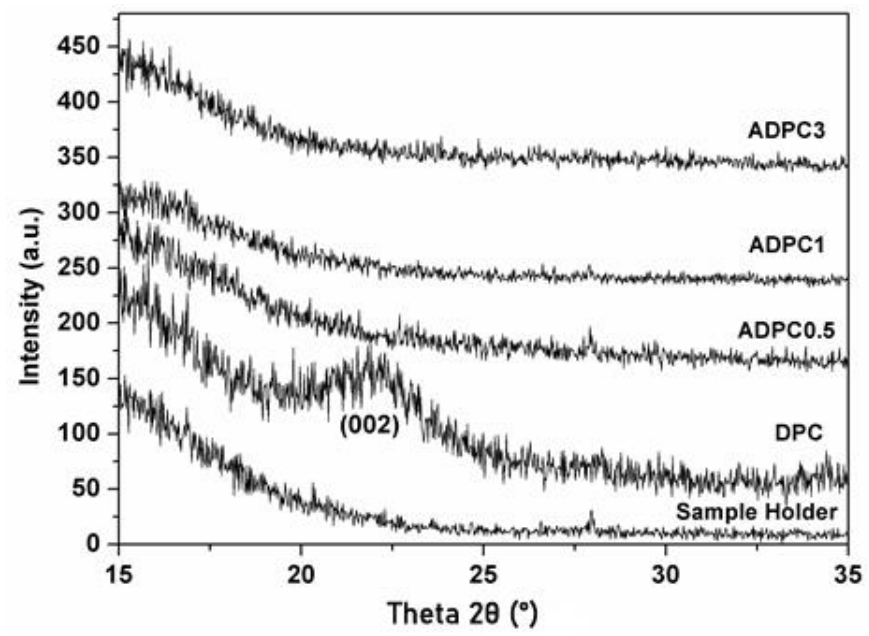
Figure 3. XRD pattern of samples between 2θ = 15° and 37°. The complete spectrum is shown in Figure S1.